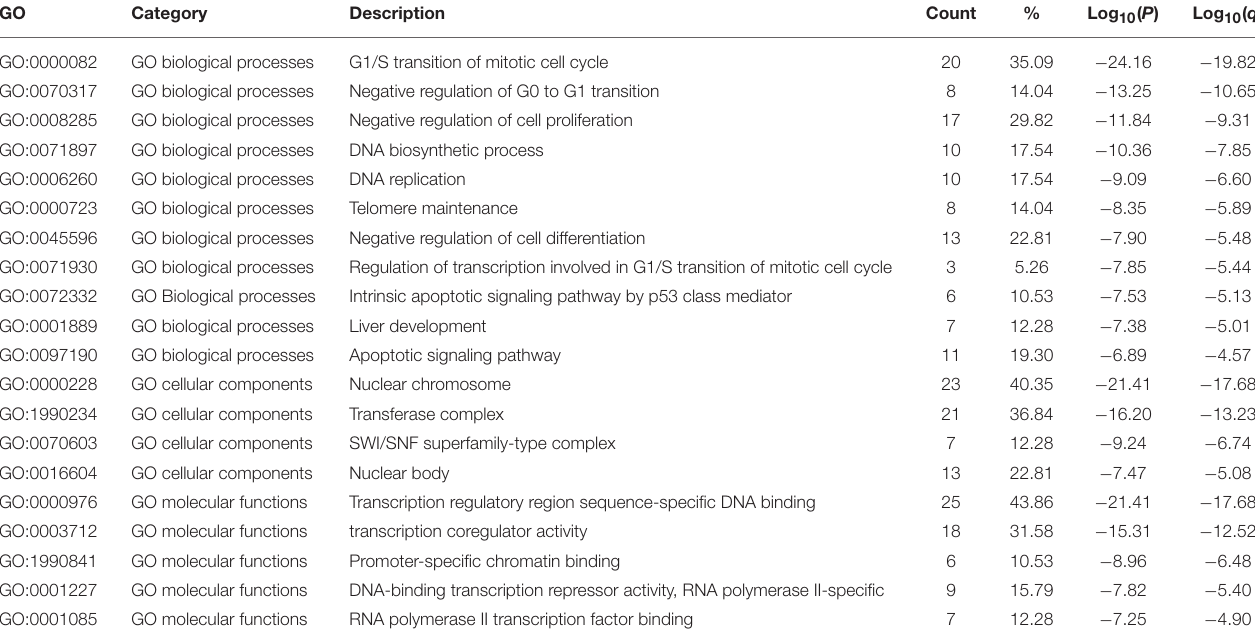
TABLE 2 | The GO function enrichment analysis of E2F family members and neighbor genes in OC (GeneMANIA).